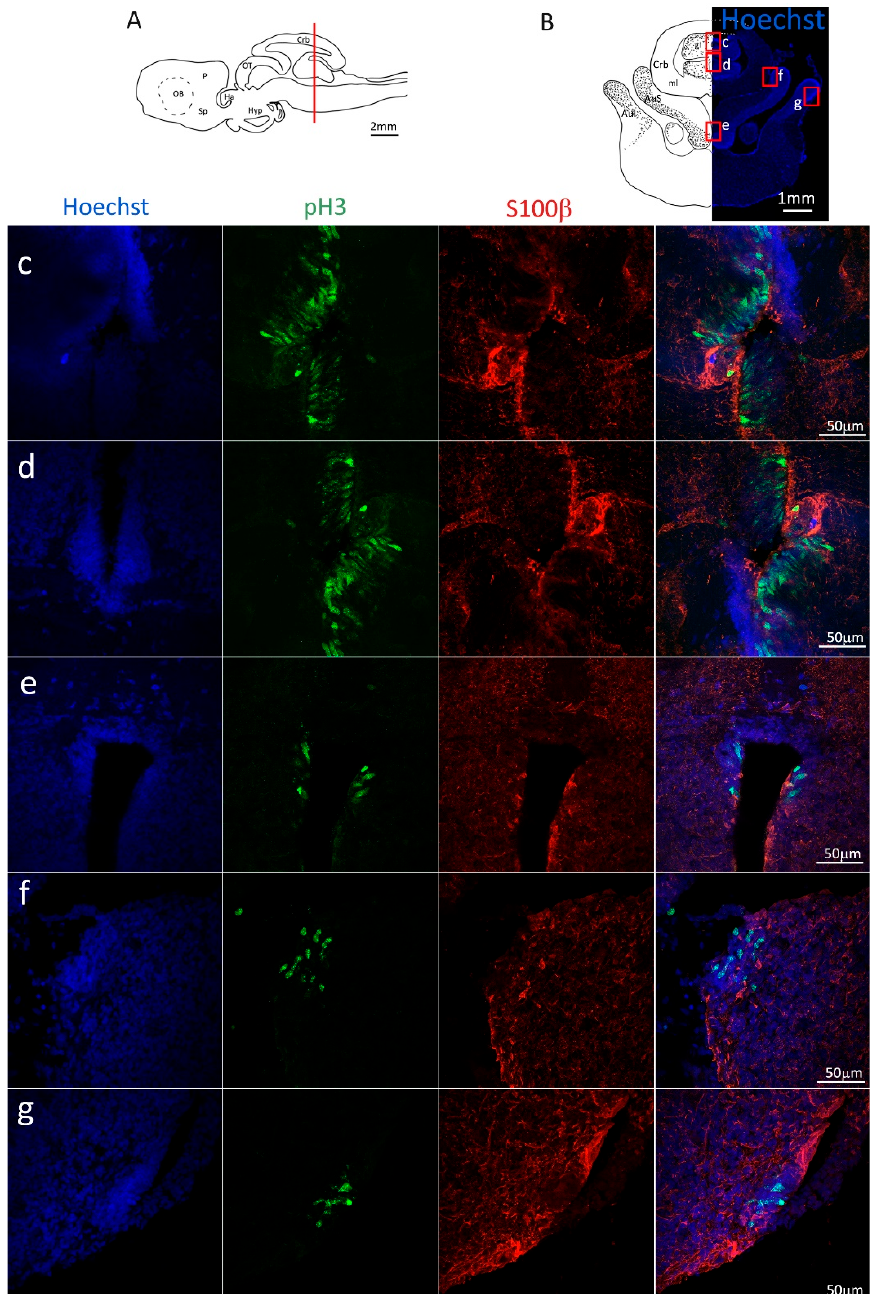
Figure 19. Localization of pH3 (green) and S100 β (red) positive cells in the mesencephalon of S. canicula . ( A ) Sagittal representation of S. canicula brain. The red line indicates the rostro-caudal localization of the section represented in the panel. ( B ) Coronal map of the area imaged. On the right, a real coronal section is stained with Hoechst 33342 to show nuclei distribution; on the left, a cartoon is drawn to indicate anatomical references. Red rectangles identify the general area from which images are taken. ( c ) Magnification of the neurogenic niche localized in the dorsal cerebellum. ( d ) Magnification of the neurogenic niche localized in the ventral cerebellum. ( e ) Magnification of the neurogenic niche localized in the medial superior cerebellar auricle. ( f ) Lateral neurogenic niche of the superior auricle. ( g ) Neurogenic niche of the inferior auricle. Abbreviations: Crb: cerebellum, gl: granular layer, ml: molecular layer, AuS: superior cerebellar auricle, AuI: inferior cerebellar auricle.